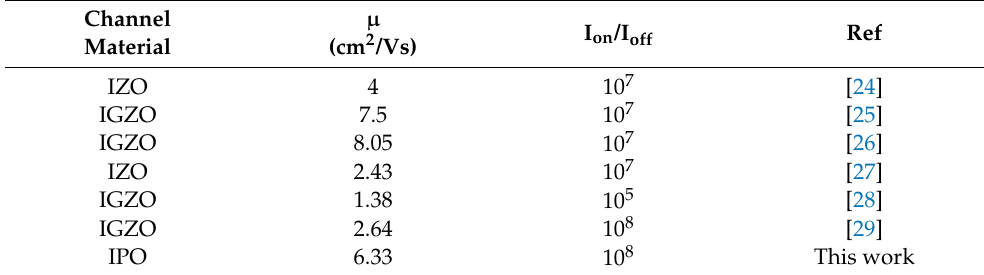
Table 3. Recent advances of solution-processed IGZO-related